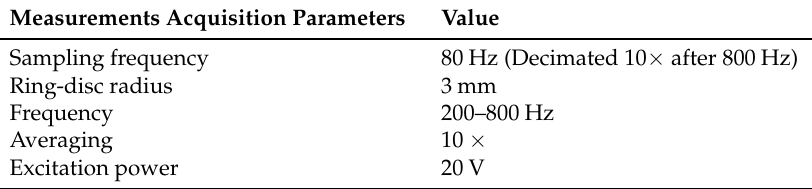
Table 1. Torsional wave elastography (TWE) technique acquisition parameters for both ex vivo liver samples and hydrogel phantoms.